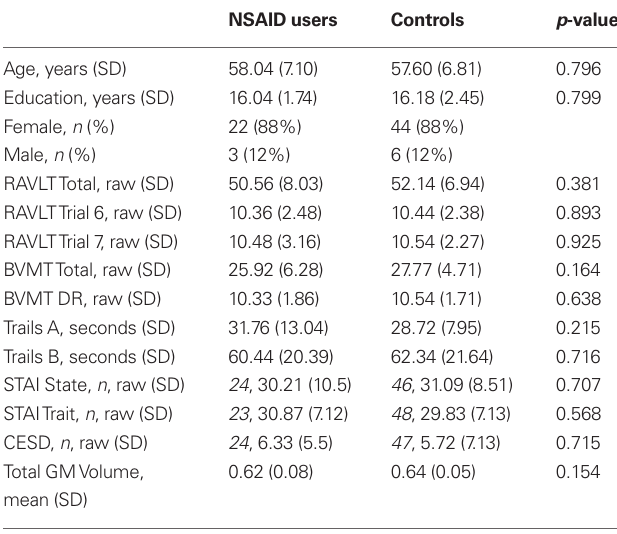
Table 1 | Demographic, neuropsychological, and gray matter volume